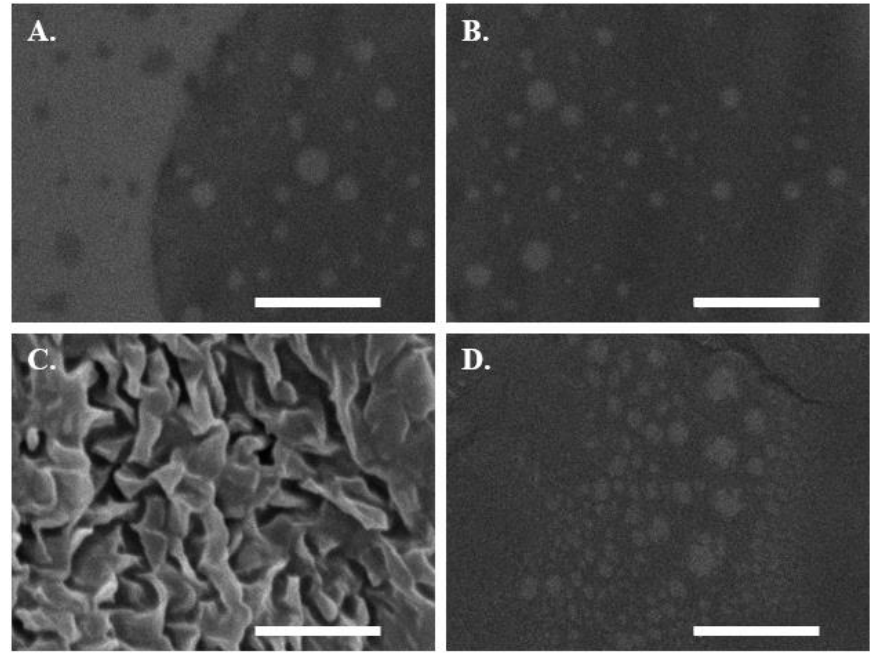
Figure 11. SEM images of the blank SEDDS ( A ) and mucoactive SEDDSs containing NAC complexes with PEI ( B ), Eudragit E 100 ( C ), and Eudragit RS 100 ( D ) permeated the mucus after 4 h incubation.